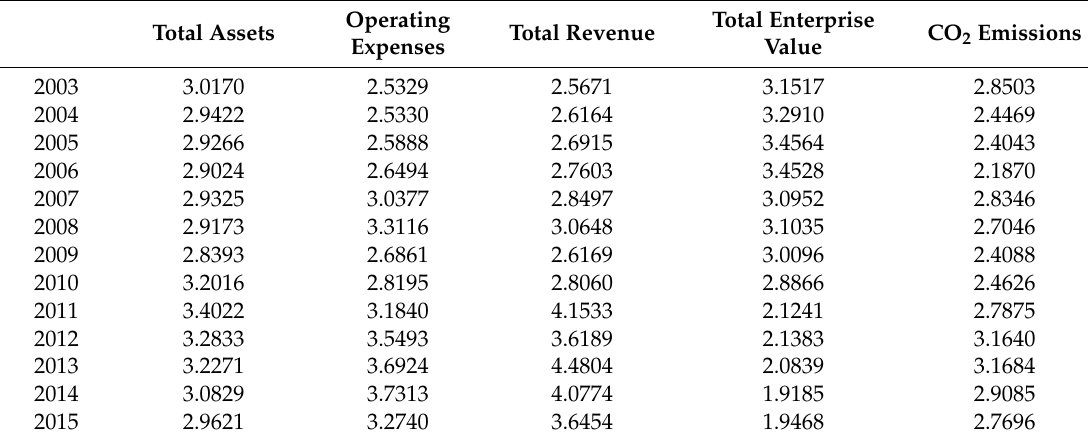
Table2. TokyoElectricPowerCompany(2003–2015):